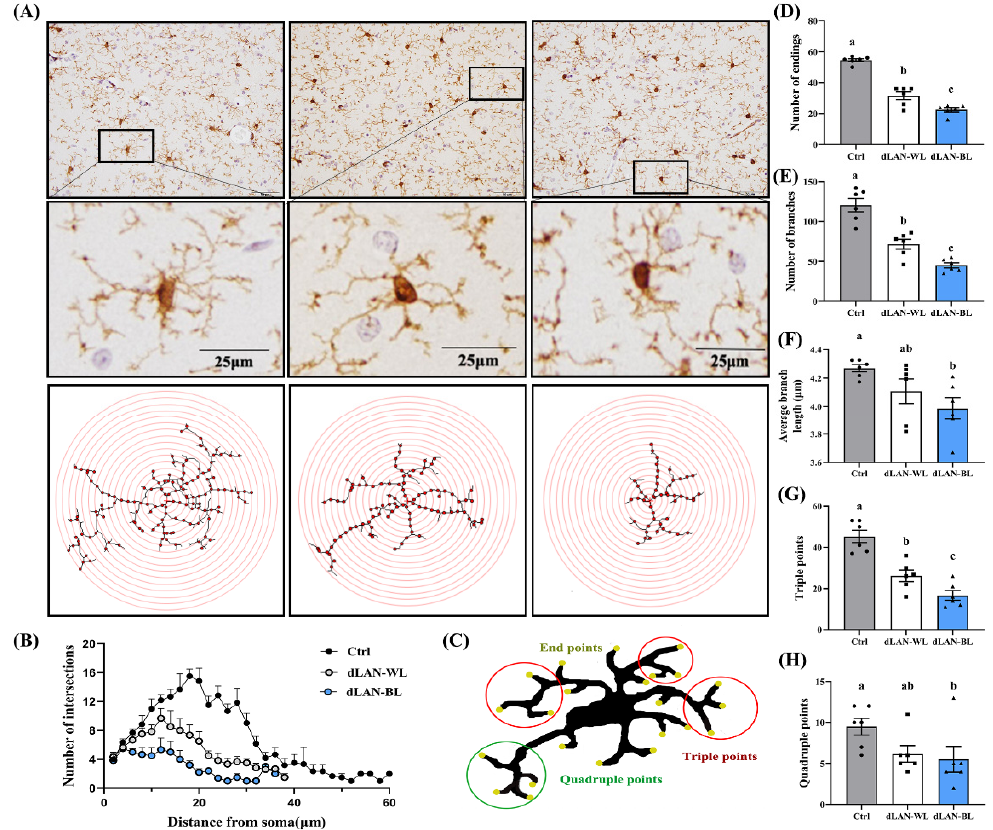
Figure 5. Effects of dLAN on microglia morphology in the hippocampus. ( A ) Schematic diagram of Sholl analysis. The results of Sholl analysis were processed using ImageJ. Bar = 25 µm. ( B ) Quantification of microglial ramification complexity using Sholl analysis ( n = 6). ( C ) Schematic example of a skeletonized microglia showing endpoints, triple junctions (junctions with exactly three branches) and quadruple junctions (junctions with exactly four branches). ( D ) Analysis of the microglial endpoints ( n = 6). ( E ) Analysis of the microglial branches ( n = 6). ( F ) Analysis of the average branch length of microglia ( n = 6). ( G ) Analysis of the triple points of microglia ( n = 6). ( H ) Analysis of the quadruple points of microglia ( n = 6). Differences were assessed using one-way ANOVA. The result represents the mean ± standard error of the mean. Values not sharing a common superscript letter (a,b) differ significantly at p < 0.05; those with the same letter (a,b) do not differ significantly ( p ≥ 0.05). Ctrl: control group, dLAN-WL: dim white light at night group, dLAN-BL: dim blue light at night